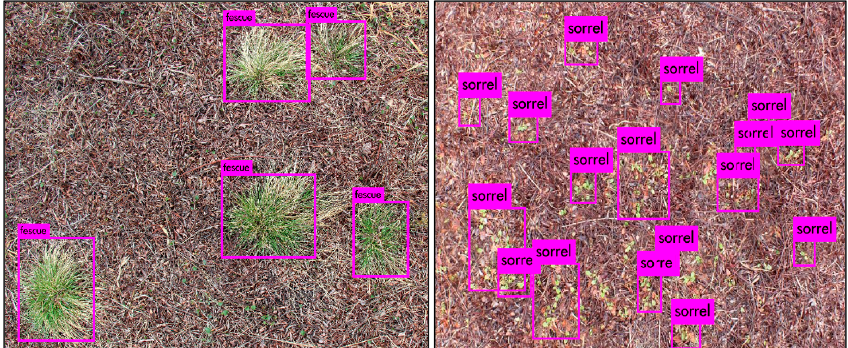
Figure 3. Examples of hair fescue ( left ) and sheep sorrel ( right ) detections on images captured in wild blueberry fields using YOLOv3-Tiny at 1280 × 736 resolution. The base hair fescue picture was captured on the morning of 24 April 2019 in Murray Siding, NS (45.3674 ◦ N, 63.2124 ◦ W), while the base sheep sorrel picture was captured on the morning of 25 April 2019 in Kemptown, NS (45.4980 ◦ N, 63.1023 ◦ W). Both pictures contain the respective target weeds with wild blueberry plants after flail mowing. The hair fescue detection picture also contains some sheep sorrel. Table 1. Object-detection results for hair fescue plants in images of wild blueberry fields. Training and validation images were captured in spring 2019, while the testing images were captured in autumn 2019. Validation Testing Network Resolution